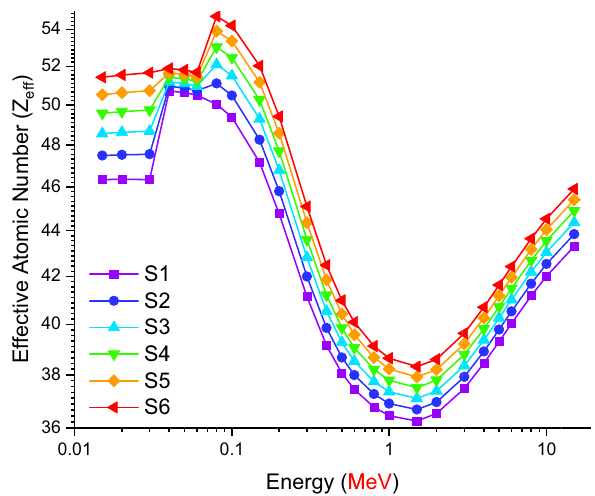
Figure 2: Variations of e ff ective atomic number ( Z e ff ) with photon energy ( MeV ) for all S1 – S6 glasses.